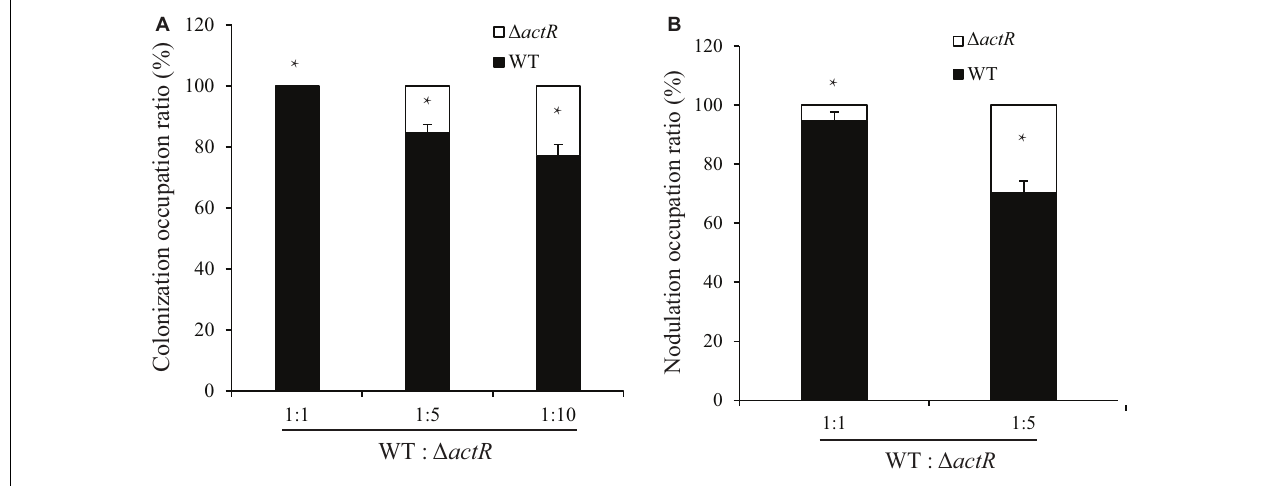
FIGURE 6 | The mutant reduced colonization and nodulation competitiveness on Sesbania rostrata. (A) Competitive colonization of wild type (WT) and (cid:49) actR mutant strains on S. rostrata root. Ratios of 1:1, 1:5, and 1:10 represent the ratio of WT to the mutant. (B) Competitive nodulation of WT and (cid:49) actR on the stems of S. rostrata . Ratios of 1:1 and 1:5 represent the WT to the mutant. Bar plot represents the mean and SD of the relative colonization ratio and the relative nodulation occupation ratio of the WT (black bar) and (cid:49) actR mutant (white bar). Means and SDs were obtained from at least three independent experiments. Student’s t -test; *represents significant difference at p <